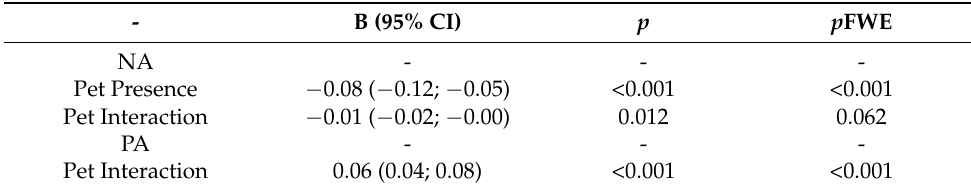
Table 4. Main effect: effect of pet presence and pet interaction.